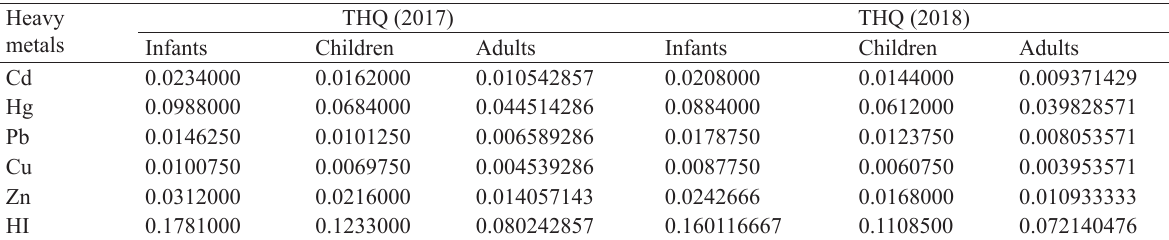
Table 4 Target hazard quotients (THQ) and hazard index (HI) of elements consumed with Mullus barbatus L. caught near the southern coast of the Black Sea in 2017 and